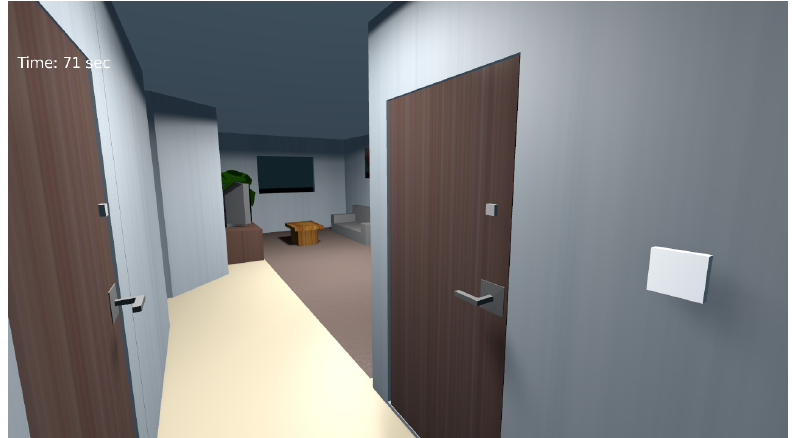
Figure 7. Navigating the smart home space through the first-person